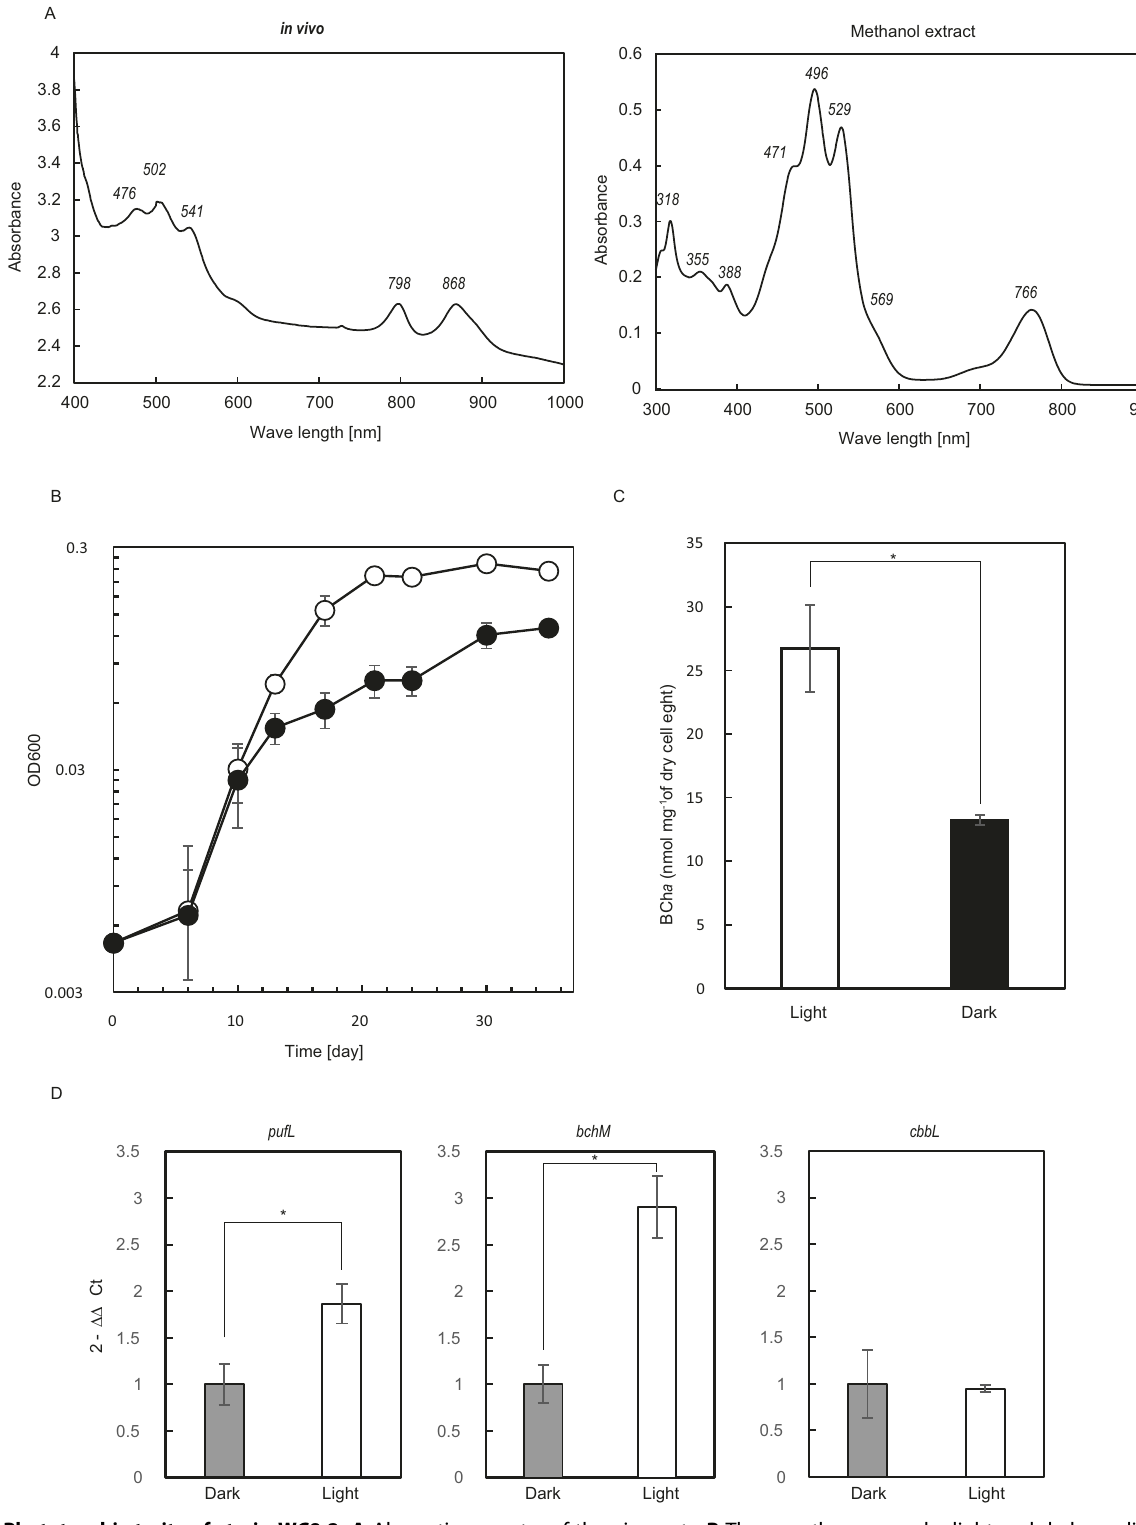
Fig. 4 Phototrophic traits of strain WC8-2. A Absorption spectra of the pigments. B The growth curve under light and dark conditions. The open circles indicate the light conditions, the closed circles for the dark conditions C The BChl a production under light and dark conditions. D Relative transcriptional levels of pufL, bchM, and cbbL under light and dark conditions. Values in B-D indicate the average of three ( A , C and D ) or six ( B ) independent cultivations. Error bars show the standard deviation of values from three independent cultivations. * P <